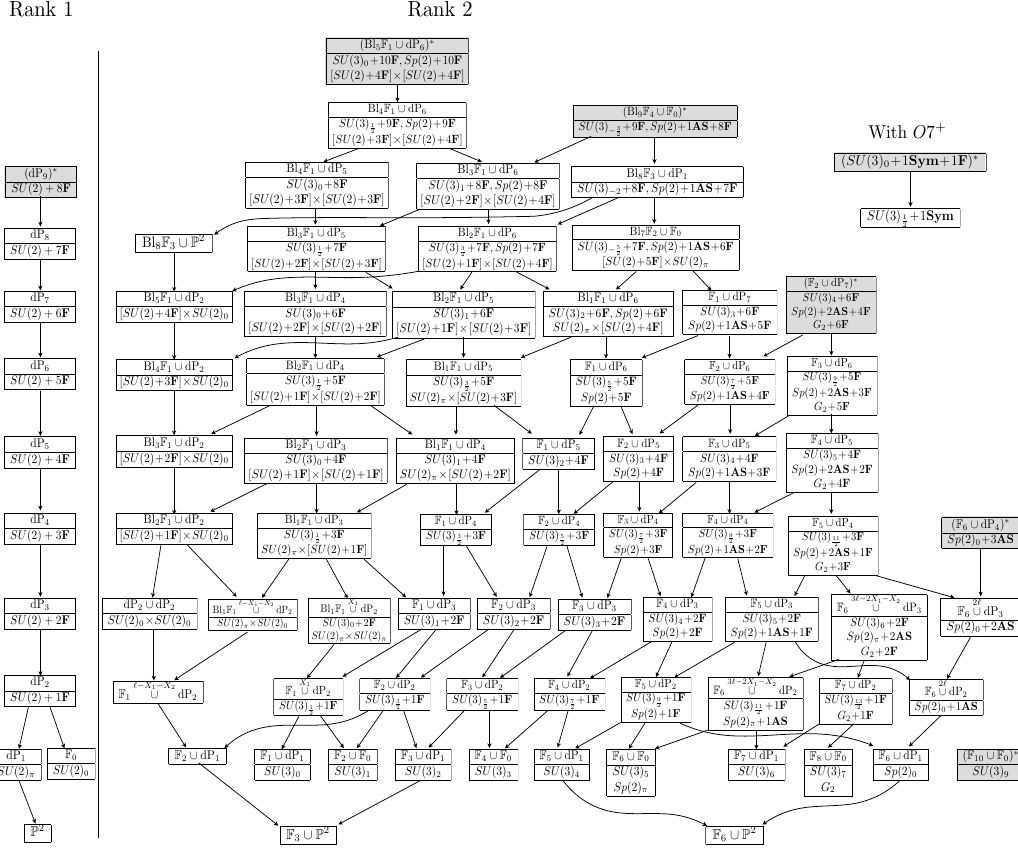
Figure 16. The diagram above shows the RG (cid:13)ow among rank 1 and rank 2 SCFTs obtained by mass deformations. The (cid:12)rst and the second rows in each box correspond to the geometric and the gauge theoretic descriptions respectively of a 5d theory. 18 The parent theory in each branch is a 5d KK theory related to a 6d theory on S 1